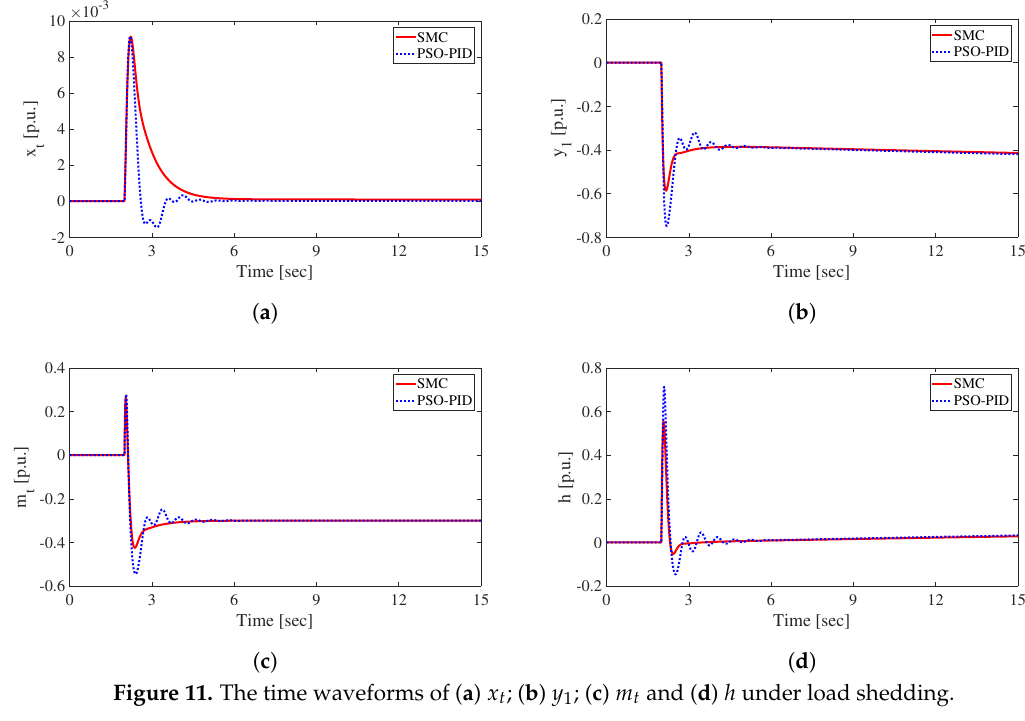
Figure 11. The time waveforms of ( a ) x t ; ( b ) y 1 ; ( c ) m t and ( d ) h under load shedding.